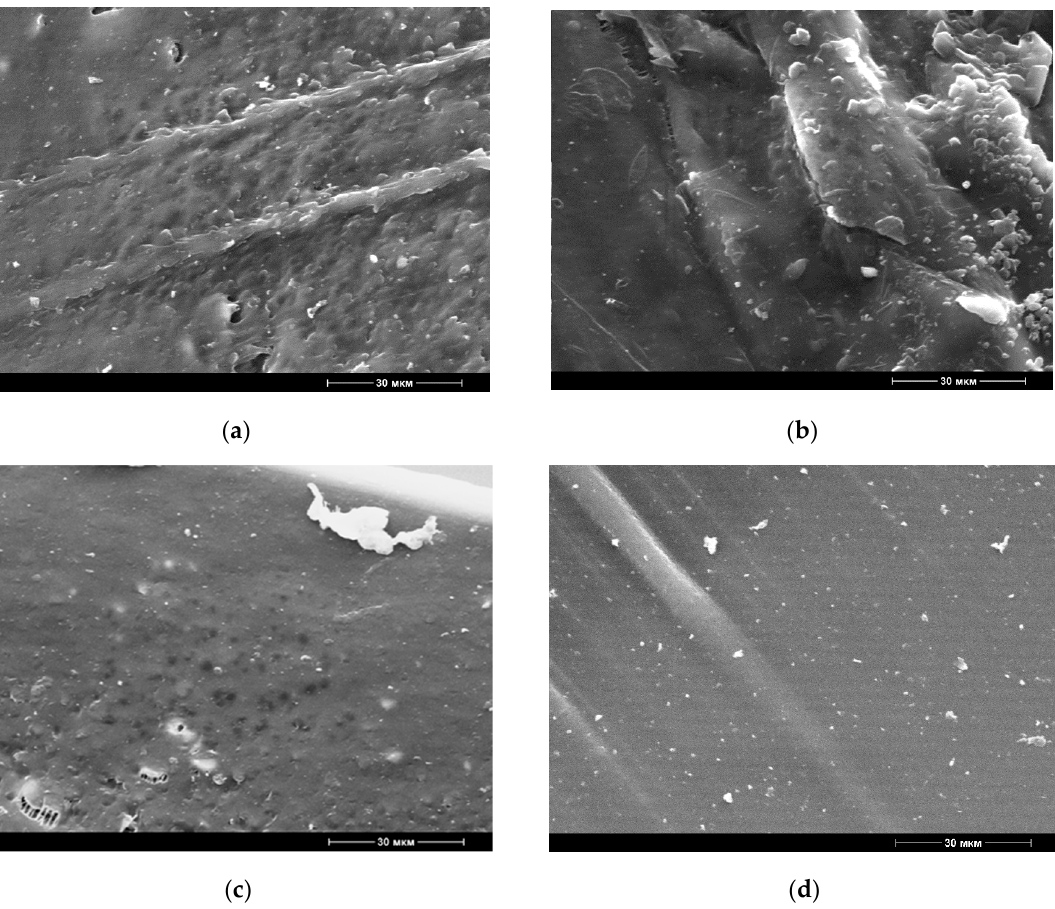
Figure 4. Micrographs of the surface structure of the samples of the materials PBAT (70,000×): ( a ) PBAT, obtained without ultrasonic treatment; ( b ) PBAT+BBE, obtained without ultrasonic treatment; ( c ) PBAT, obtained with ultrasonic treatment; ( d ) PBAT+BBE, obtained with ultrasonic treatment.